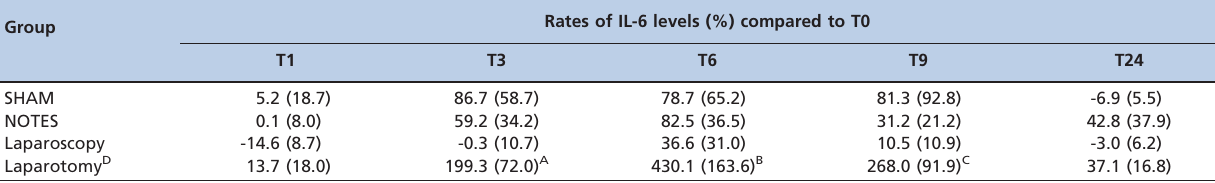
Table 5 - Interleukin 6 (IL-6) levels during the 24 h following the procedure. Group Rates of IL-6 levels (%) compared to T0